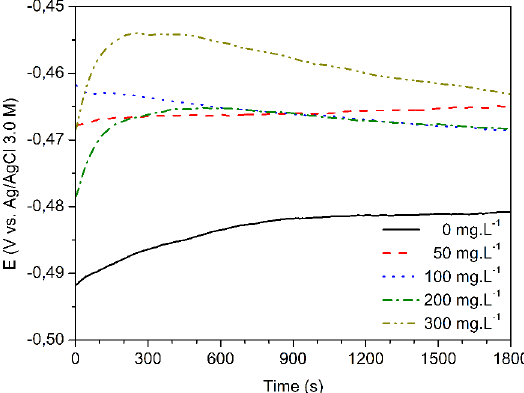
Figure 3. Open circuit potential of C-steel in 1.0 mol∙L -1 HCl Aniba canelilla stem extract at the concentrations 0, 50, 100, 200 and 300 mg∙L -1 .